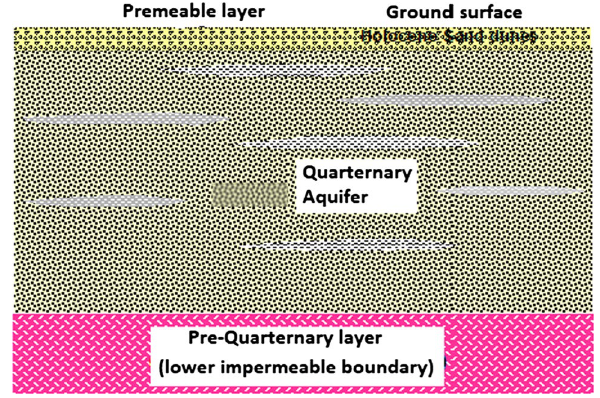
Fig. 4 Conceptual model of a two dimensional model (one vertical layer) Quaternary unconfined aquifer in the 10th of Ramadan city